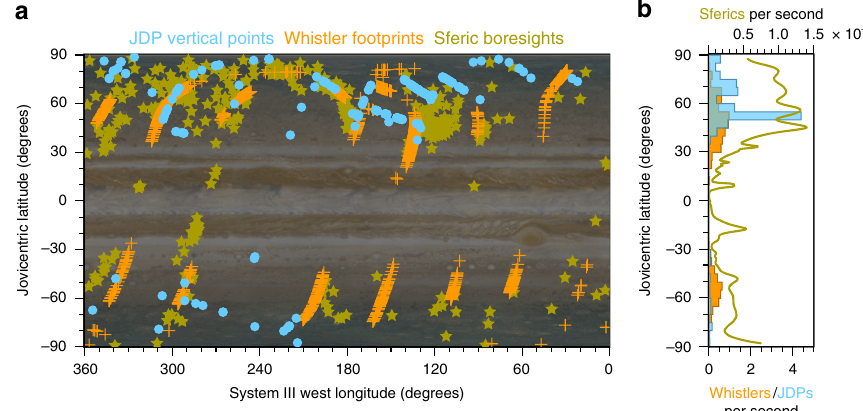
Fig. 3 Jovian global map of JDPs, lightning-induced whistlers and sferics. a The blue circles depict the vertical projection of Juno when JDPs were captured. The orange plus marks indicate the whistler footprints that were mapped along the JRM09 magnetic fi eld lines 19 onto the Jovian atmosphere at altitude of 300 km above the 1-bar level. The yellow stars are the MWR boresights at the 1-bar level for the detections of sferics at 600 MHz. These data were taken from the Juno Waves whistler catalogue 3 and the Juno MWR sferic catalogue 5 from perijoves 1 through 8. Note that the region between 200° and 280° where JDPs present were sampled from the Juno perijove 9 orbit where sferic and whistler observations have not been completed. The Jovian image was provided by NASA/JPL-Caltech/SSI/SwRI/MSSS/ASI/INAF/JIRAM/Björn Jónsson (http://www.planetary.org/multimedia/space-images/jupiter/ merged-cassini-and-juno.html). b Their latitudinal pro fi les of detection rate are shown using corresponding colours. In addition, the comparison of JDPs with the previous optical detections of lightning is shown in Supplementary Fig.